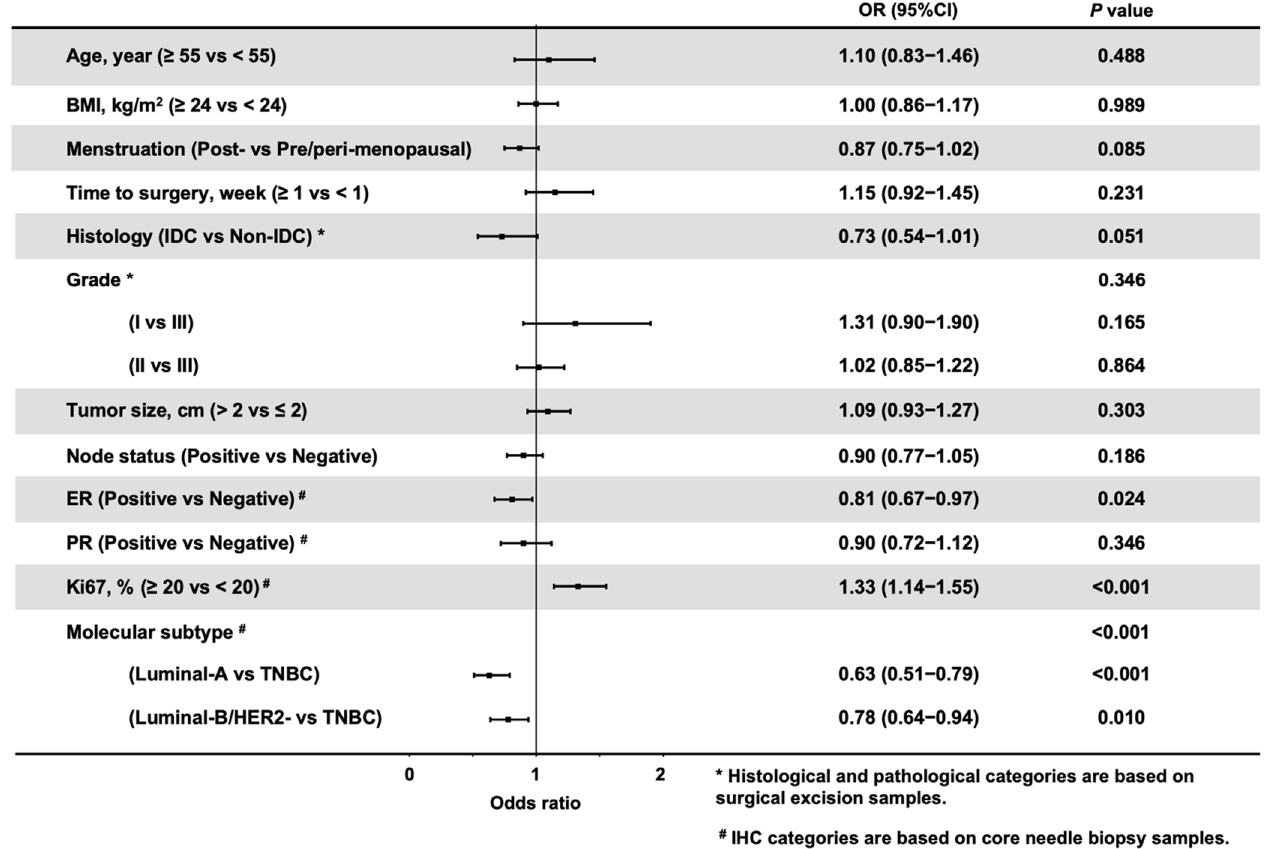
Figure 4. Forest plot of adjusted odds ratios of factors associated with HER2 discordance in HER2- Negative patients. The adjusted estimates were from the logistic model. # IHC categories are based on core needle biopsy samples. * Histological and pathological categories are based on surgical excision samples. Abbreviations: HER2, human epidermal growth factor receptor-2; BMI, body mass index; IDC, invasive ductal carcinoma; ER, estrogen receptor; PR, progesterone receptor; IHC, immunohistochemistry; TNBC, triple negative breast cancer.